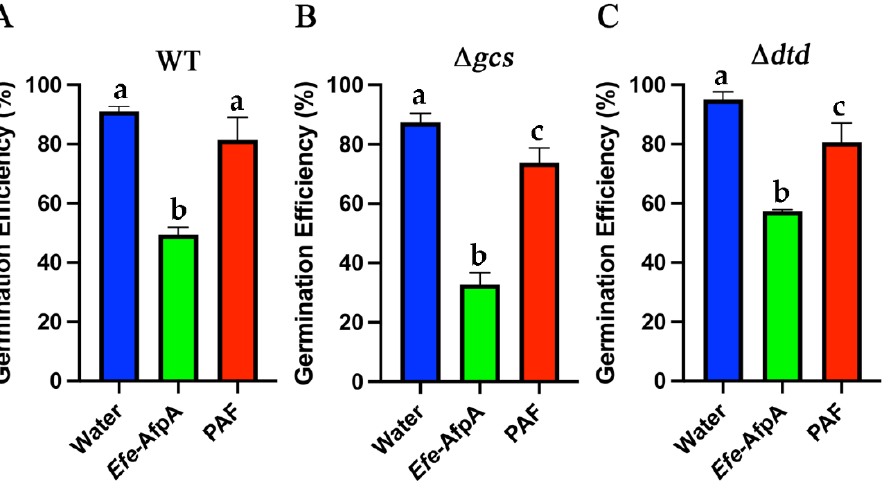
Figure 12. Effect of Efe -AfpA and PAF on conidia germination of N. crassa wild type ( A ) and glucosylceramide pathway mutants ( B , C ). Conidia (100 µ L of 1 × 10 5 conidia mL − 1 ) were treated for six hours with either water or an antifungal protein at 10 µ g mL − 1 . One-hundred conidia were counted as either germinated or ungerminated. The data presented are the means and standard deviations of three replicates. For each N. crassa strain, columns with different letters indicate a significant difference in activity ( p ≤ 0.05, one-way ANOVA).